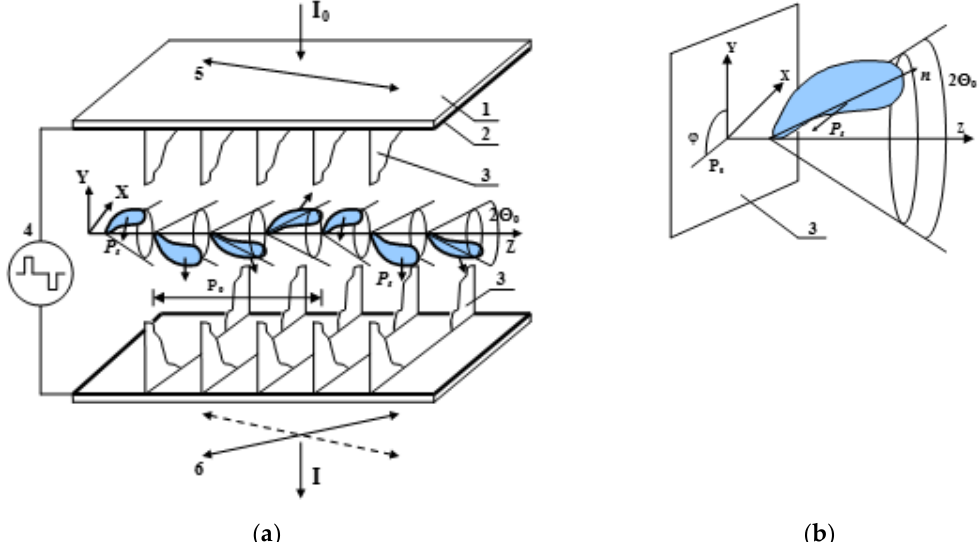
Figure 1. The helix ferroelectric liquid crystal (FLC)-based electro-optical cell with planar orientation of a layer ( a ) and mutual location of the spontaneous polarization vector Р S , a smectic layer, and FLC director n ( b ). I 0 and I are the intensities of the incident light and the light passing through an FLC cell, correspondingly. 1 — glass substrates with conductive covers 2; 3 — smectic layers; 4 — generator of bipolar pulses; 5 and 6 — polarizers; p 0 — helix pitch; Θ 0 — angle of molecule tilt in smectic layers.